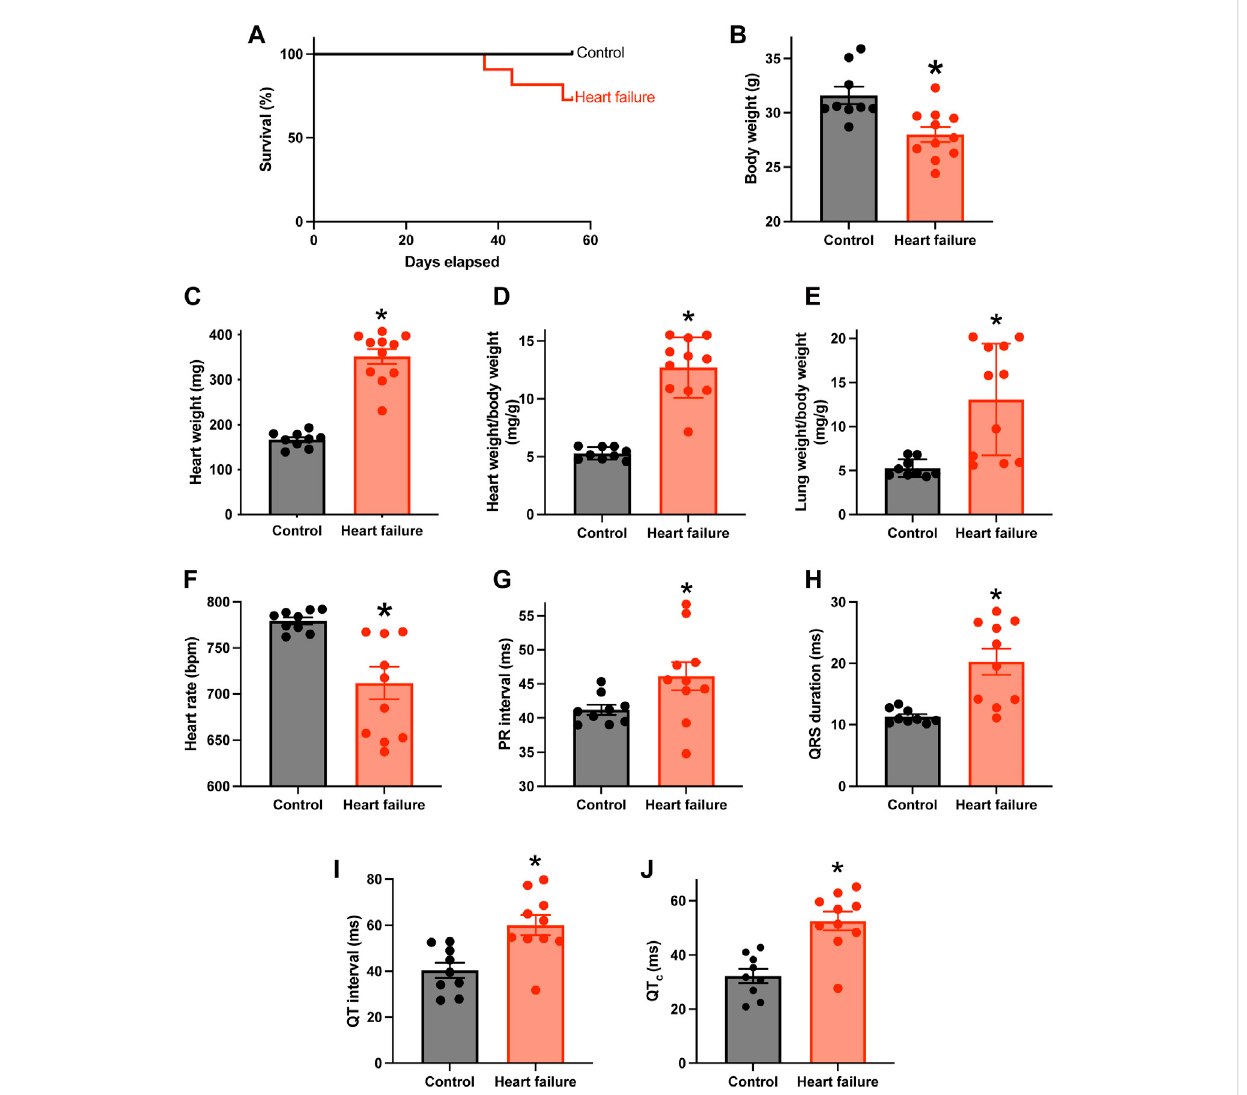
FIGURE 1 HFmodelwithAVnodedysfunction. (A) ,percentagesurvivalofcontrol( n =9;subjectto shamsurgery)andHF( n =11; subjecttoTACsurgery)mice in the days following surgery. (B – F) , body weight (B) , heart weight (C) , heart weight:body weight ratio (D) , lung weight:body weight ratio (E) and in vivo heart rate ( (F) ; measured using the ECGenie) of the two cohorts of mice ( n = 9 and 11) at the end of the experiment. (G – J) , PR interval (G) , QRS duration (H) , QT interval (I) and corrected QT interval (J) of the two cohorts of mice ( n = 9 and 10) measured in the anaesthetised animals at the end of the experiment. In B-J, means ± SEM as well as individual data points shown. * p <